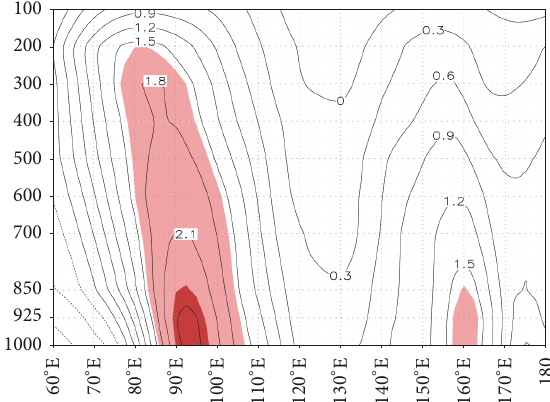
Figure 7: The 𝑡 -test of 𝐷 -values for the GH anomalies along 30 ∘ S between flood and drought years. Significant values exceeding the 90%, 95%, and 99% confidence levels ( 𝑡 -test) are shaded.